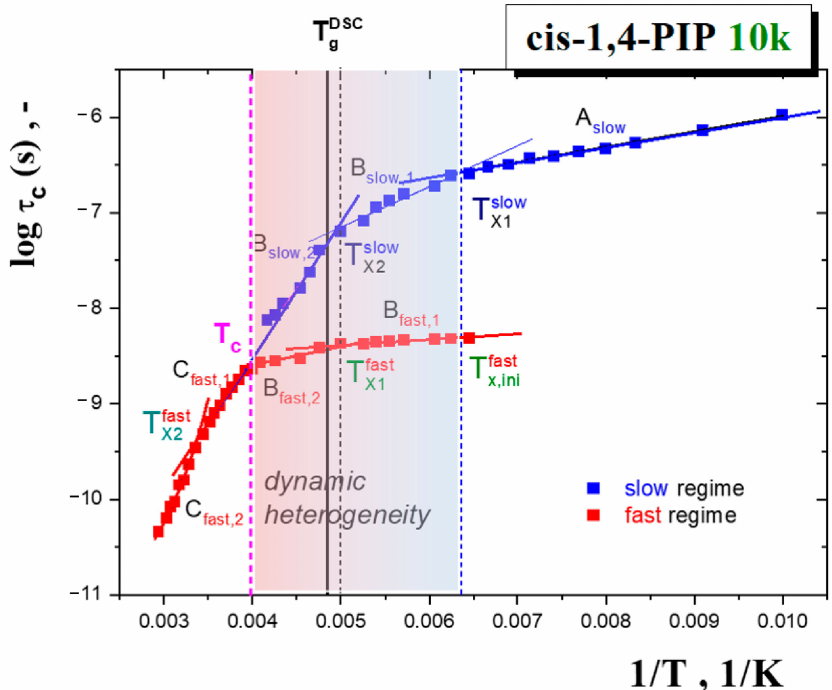
Figure 3. Arrhenius plot of the correlation time of TEMPO probe in cis -1,4-PIP10k medium exhibits two unimodal regions, i.e., low- T region A and high-T region C and one superimposed bimodal region B with the dynamic heterogeneity of the spin probe TEMPO mobility from T X1slow = T X,inifast ~155 K, to T c ~250 K [40]. The second acceleration of TEMPO within slow regime at T X2slow ~203 K and the first one within fast one at the same temperature T X1fast ~203 K together with the second change within fast regime at T X2fast = 295 K are observed. The glass-to-liquid transition at T gDSC is marked by the vertical line. The regions A slow , B slow,1 , B slow,2 , B fast,1 , B fast,2 , C fast,1 and C fast,2 , are fitted by the Arrhenius Equation or Vogel-Fulcher-Tammann-Hesse (VFTH) Equation with the fitting parameters listed in Table